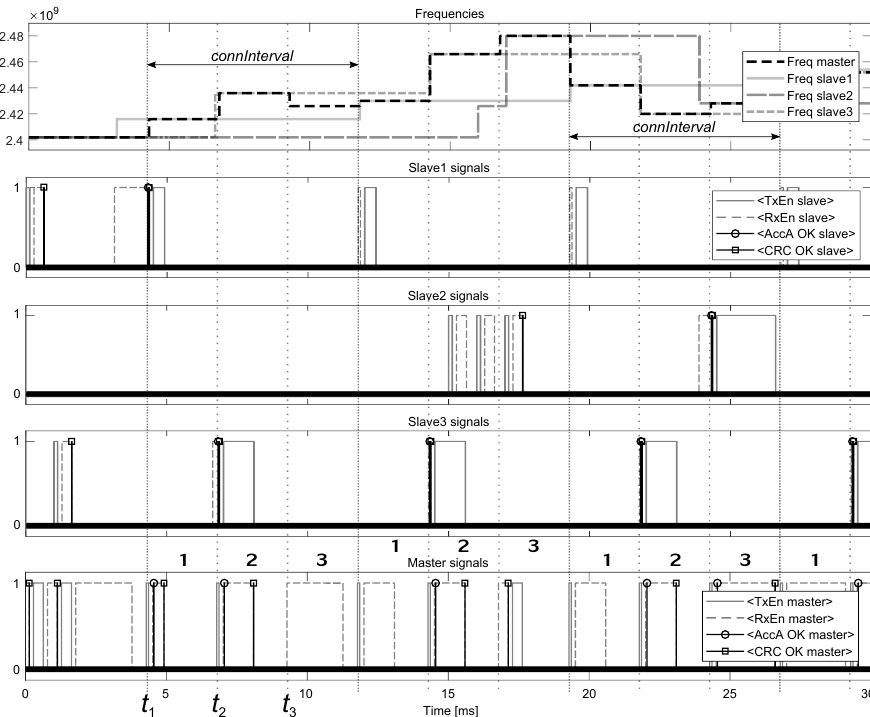
Figure 19. Internal signals of S1, S2, S3 and M1 (model M 1S4 ) from 0 to 30 ms: S1, S2 and S3 create and establish the connection with M1 at 0.632 ms and 4.364 ms, 17.631 ms and 24.364 ms, 1.631 ms and 6.864 ms, respectively (starting from 11 ms, the input and output RF signals of S1 are disabled), while M1 creates and establishes the connections with S1, S2 and S3 at 0.632 ms and 4.914 ms, 17.631 ms and 26.602 ms, 1.631 ms and 8.094 ms, respectively (after creating the connections with the slaves, the channel frequencies of M1 and S1, M1 and S2, M1 and S3 conform in the subintervals 1, 3 and 2 (numbered above the lower window),